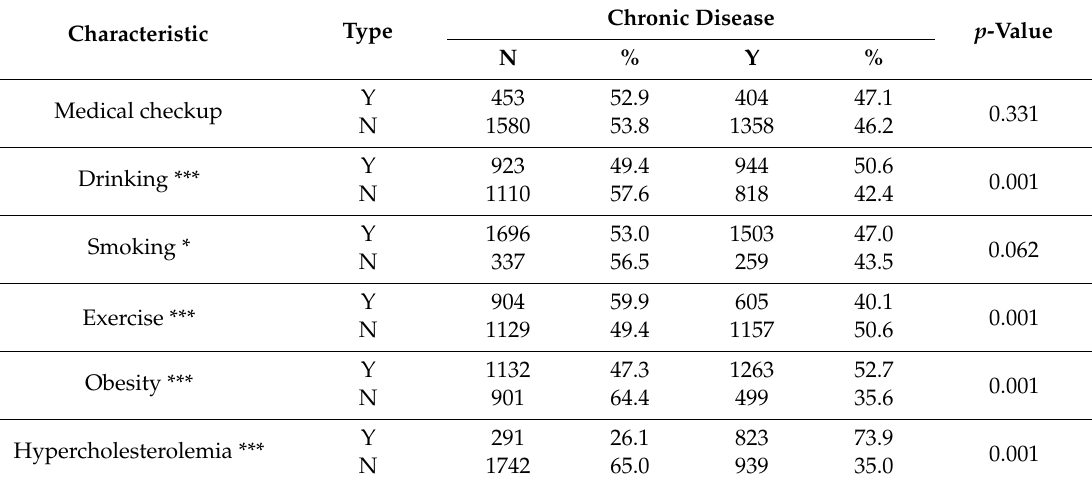
Table 4. Relationship between health behavior and chronic diseases.